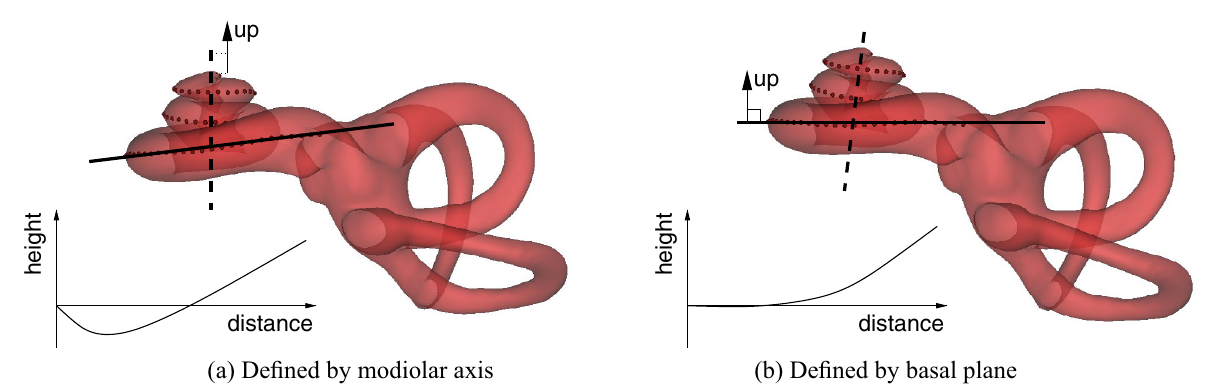
Figure 4. Clinically relevant measurements. In evaluating the success or otherwise of the model fit, we consider the cochlea’s non-planarity, reach and duct length. The non-planarity and reach measurements are made on the first 270 ◦ of the basal turn (red), ignoring the rest of the spiral (blue). Cochlear duct length is measured from the round window to the apex, along the outer (lateral) wall. The basal plane (black dotted line) is defined as the best fit plane to the first 270 ◦ of the outer wall contour. Since we do not detect the modiolus in this study, the 270 ◦ angle is not measured in the usual polar coordinate system defined by the modiolus (origin) and the round window ( 0 ◦ ). Instead, we consider the angle through which the tangent to the outer wall contour has turned with respect to its initial trajectory at the round window. 270 ◦ in this paper’s notation corresponds to somewhat more than 270 ◦ in round window/modiolar polar coordinates.